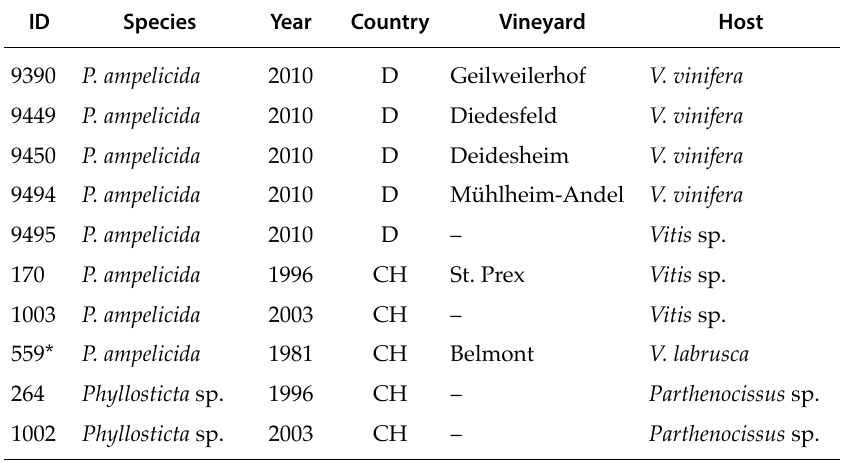
Table 1. Cultures of Phyllosticta analyzed in this study. CH, Switzerland; D, Germany. *Lyophilized